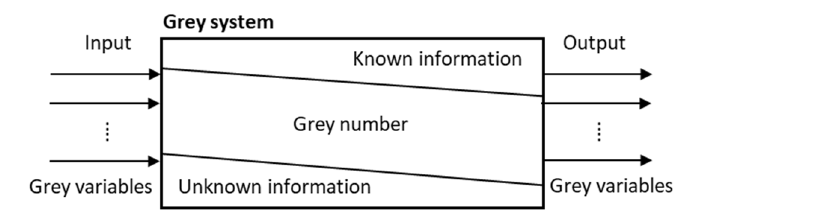
Figure 1. The proposed research framework used in this paper.